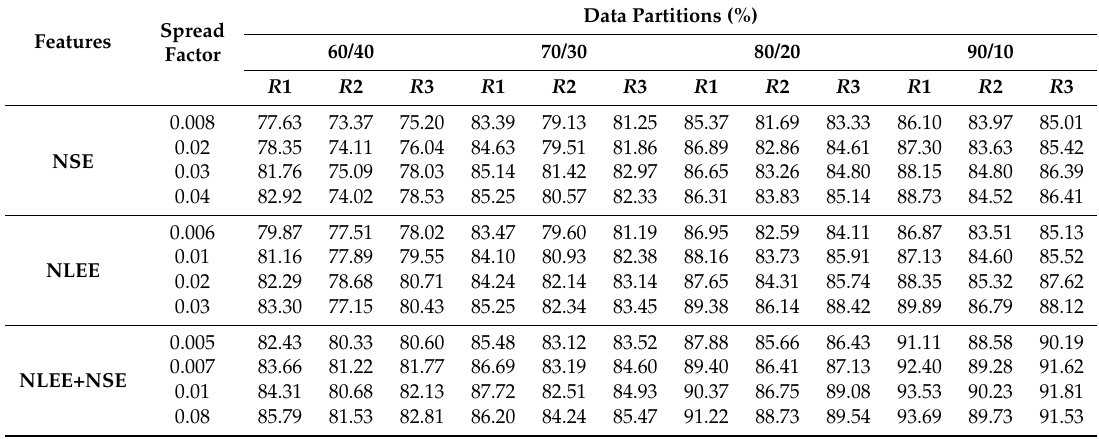
Table 4. PNN classification results at level 6 of wavelet packet decomposition using “db1”. Features